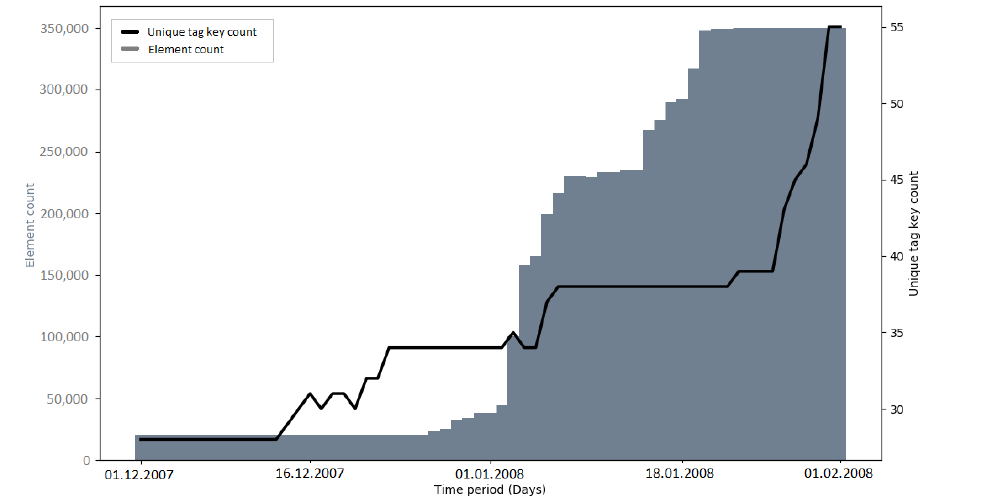
Figure A20. Number of tag keys during the PGS